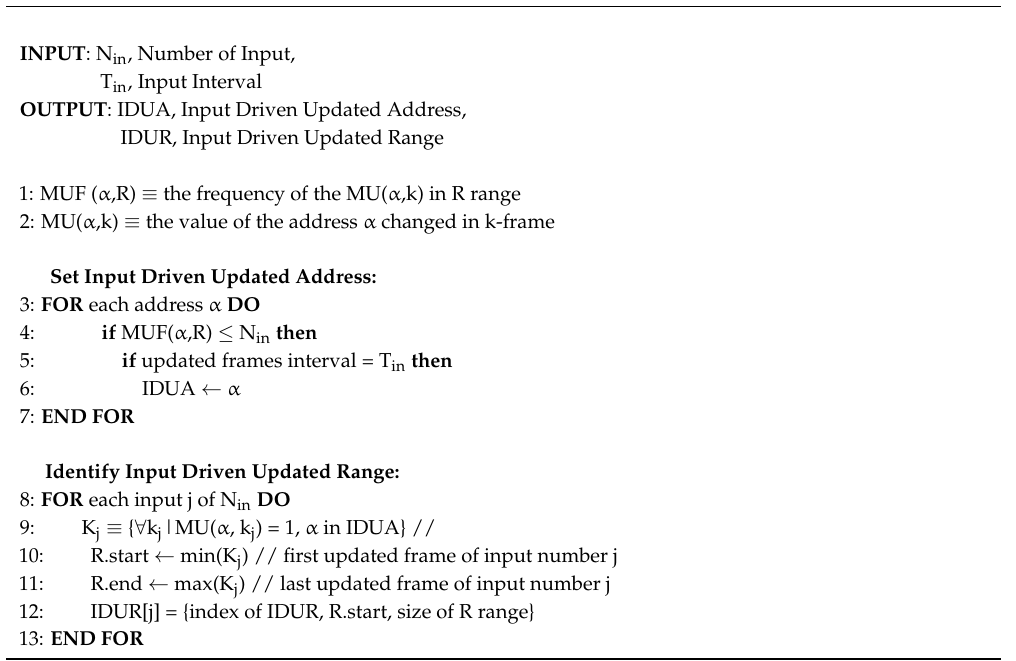
Algorithm 2. The Algorithm for Input Driven Updated Range